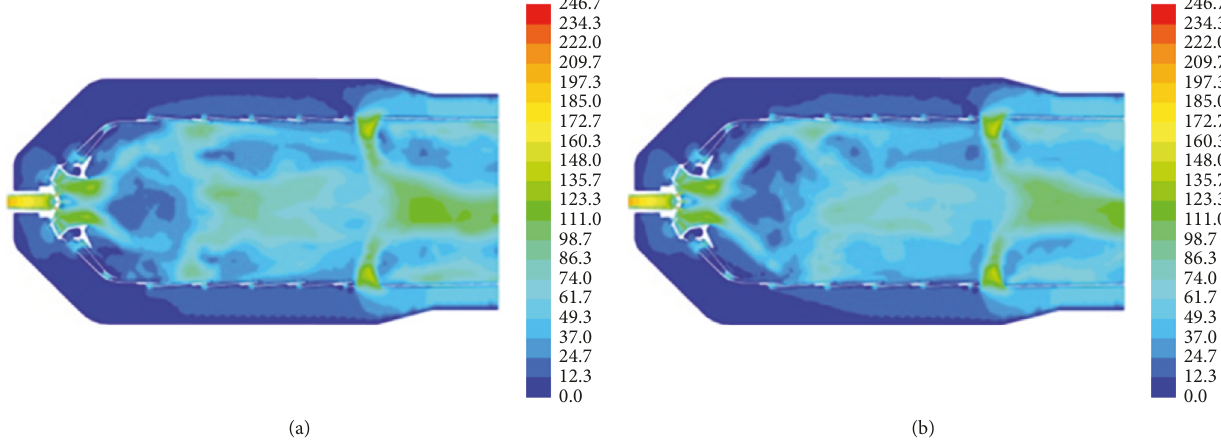
Figure 11: Distribution of the velocities in the longitudinal section of the combustor, m/s: (a) mechanism 1; (b) mechanism 2.